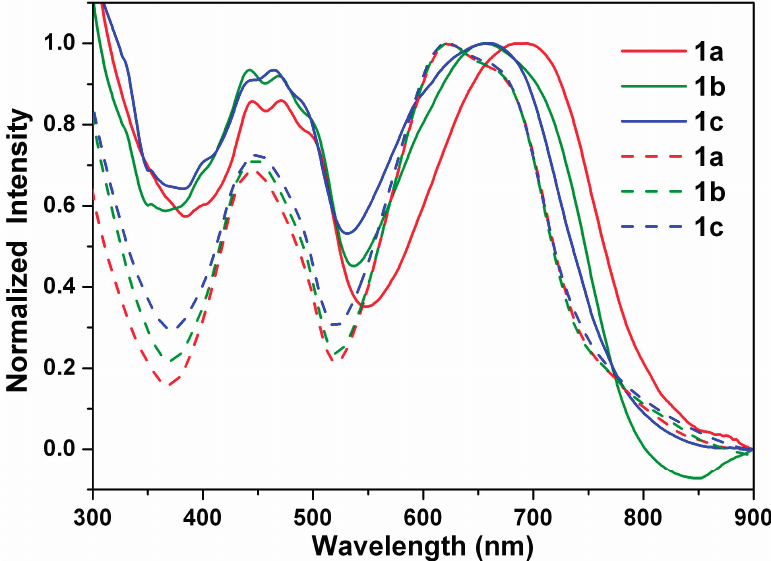
Figure 10. Normalized absorption spectra of 1a – 1c in cyclohexane solution (dashed line) and in neat film (solid